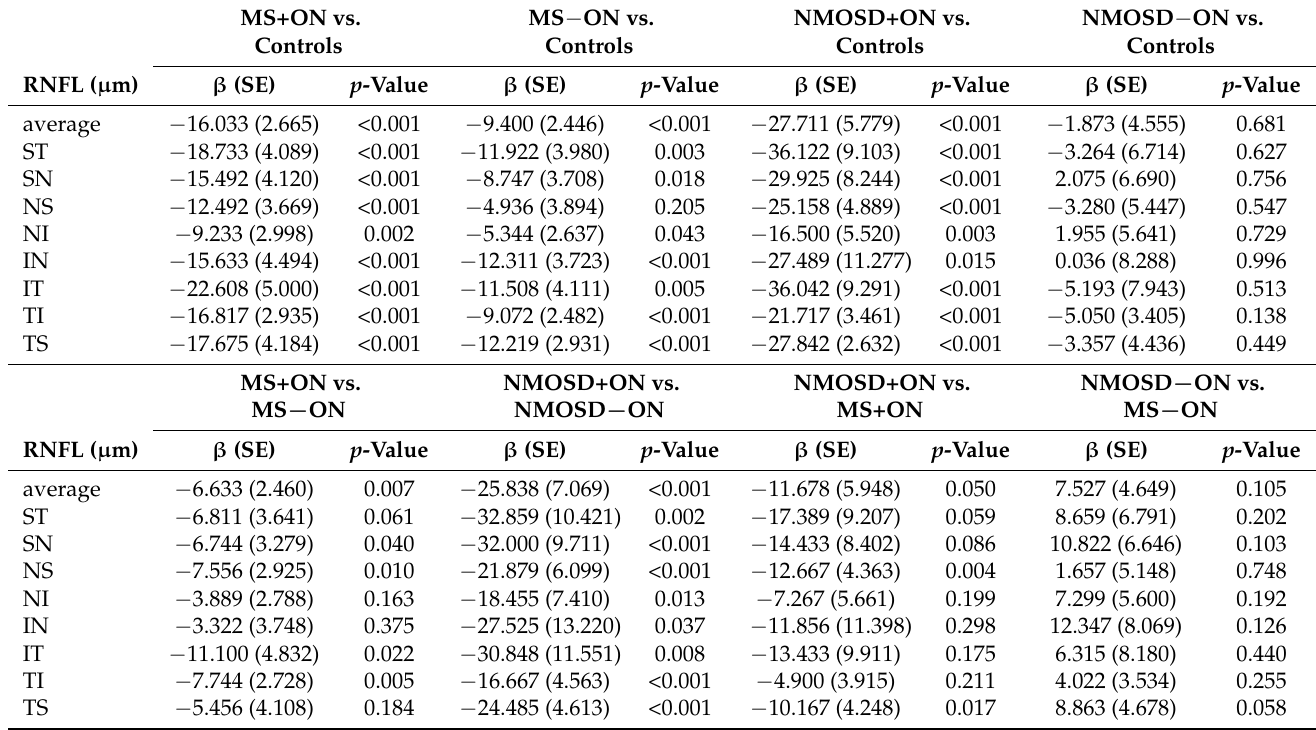
Table 3. Differences in RNFL thickness among patients and controls.